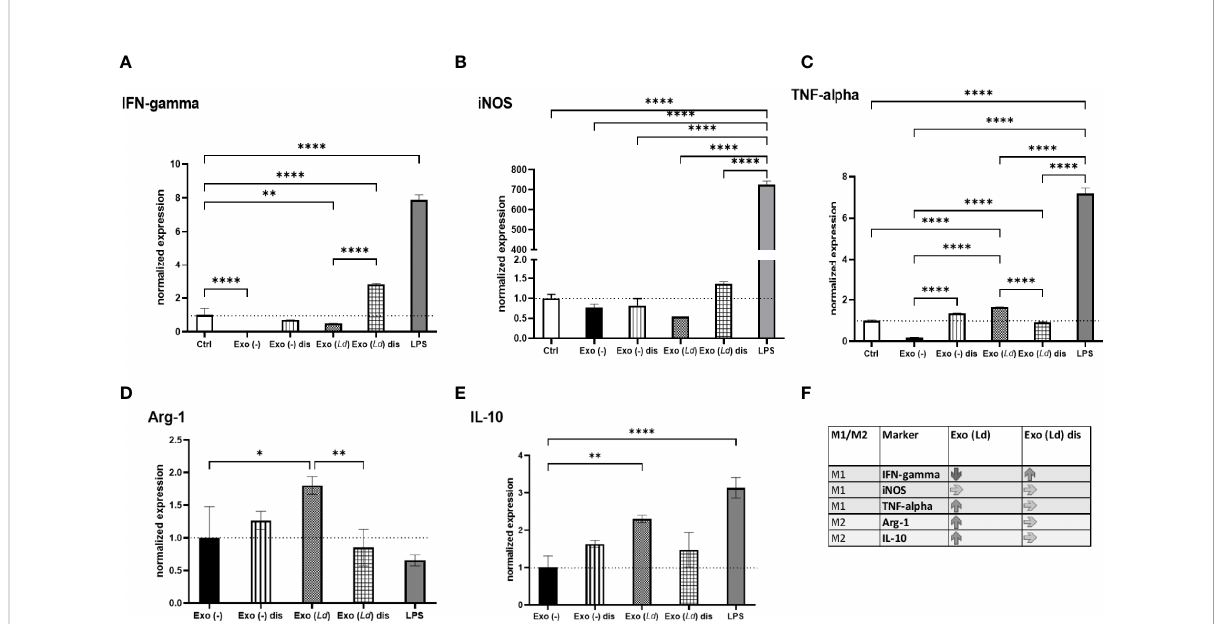
FIGURE 5 The effect of EVs derived from L. donovani -infected macrophages on macrophage polarization. RAW264.7 macrophages were infected with L. donovani (or not), and the EVs were obtained from these cells using the ultracentrifugation method. A portion of the vesicles was disrupted by sonication. Naïve macrophages were then exposed to these EVs for 24 hours. Media, EVs from uninfected cells, and LPS [100 ng/mL] were used as control treatments. The cells were collected, and RNA puri fi ed for RT-qPCR analysis of IFN-gamma (A) iNOS (B) , TNF-alpha (C) , Arg1 (D) , and IL-10 (E) transcripts. One-way ANOVA was used to establish statistical signi fi cance. N=6. Exo (-), EVs from uninfected cells; Exo ( Ld ), EVs from cells infected with L. donovani; Exo (-) dis, disrupted EVs from uninfected cells; Exo ( Ld ) dis, disrupted EVs from cells infected with L. donovani ; Ctrl, cells not treated. (F) Summary of the results indicating up- or down-regulation of M1 and M2 markers. *P ≤ 0.05; **P ≤ 0.01; ***P ≤ 0.001; ****P ≤